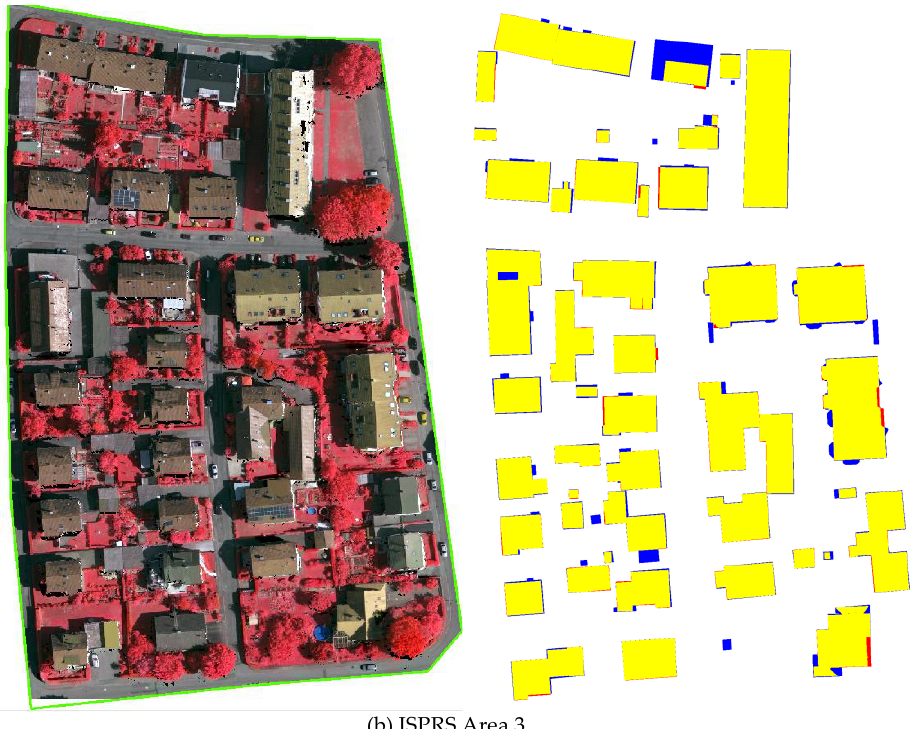
Figure 15. Evaluation results of the reconstructed roof plane. Blue: false-negative pixels (FN), yellow: true-positive pixels (TP), red: false-positive pixels (FP).